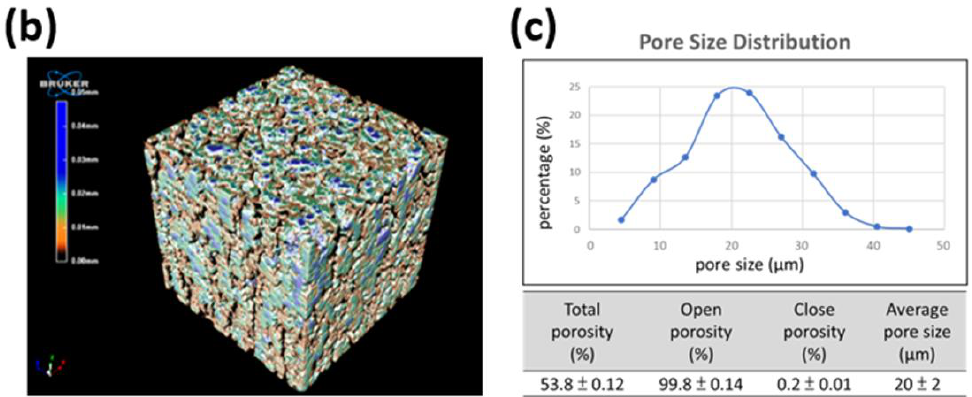
Figure 3. The characterization of the porous structures and porosity. ( a ) Scanning electron microscopy (SEM) images showed that cube-shaped ice templates, with the dimensions of 300 μm × 300 μm × 300 μm, were used to form porous maleimide-functionalized poly- p -xylylene materials by the proposed fabrication method. ( b ) A reconstructed micro-CT image shows the three-dimensional structure and the pore structures. ( c ) The calculated pore size distribution based on a micro-CT analysis suggests an interconnected pore structure (high open porosity) with an average porosity of 53.8 ± 0.12% and an average pore size of 20 ± 2 μm.